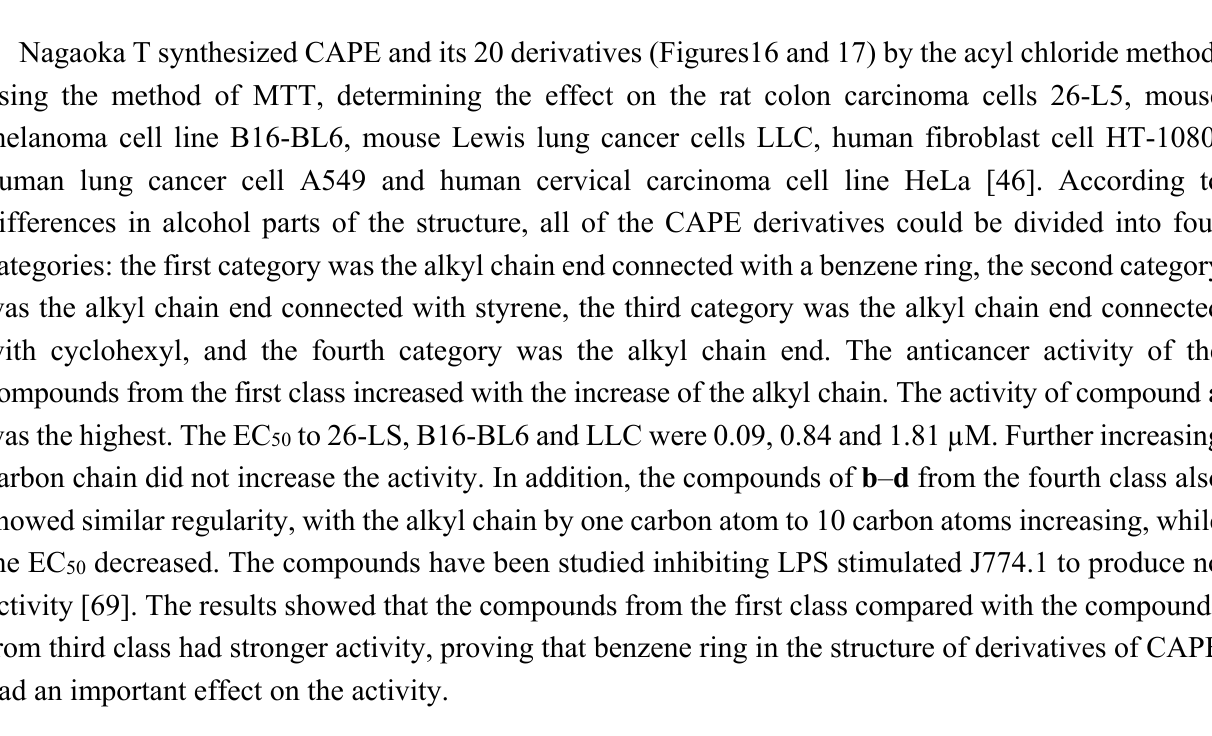
Figure 16. The scheme of elongation alkyl derivatives of CAPE.